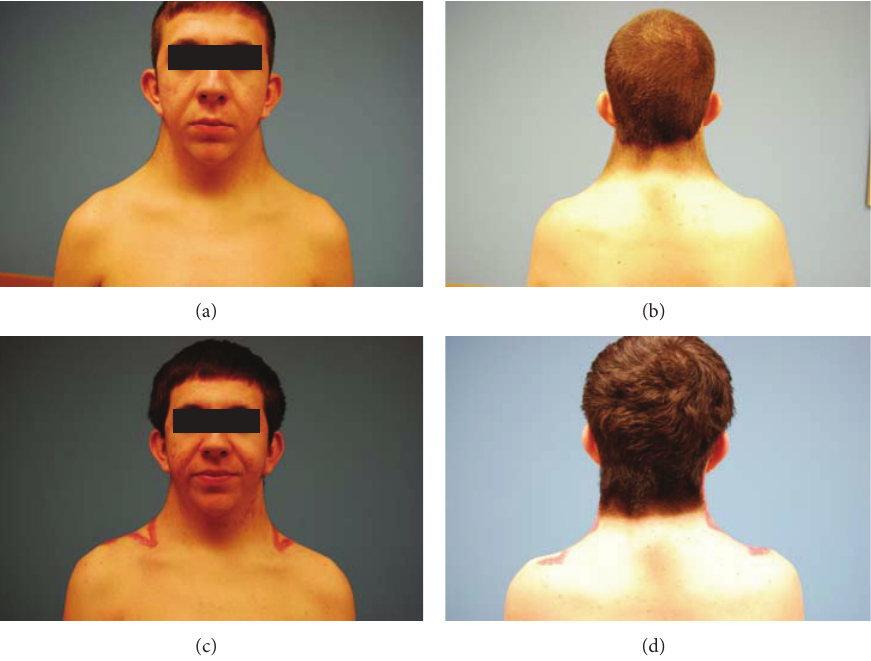
Figure 7: (a) Preoperative appearance demonstrating webbed neck deformity of Noonan syndrome; (b) preoperative low and laterally displaced nuchal hairline; (c) anterior appearance one year after surgical correction of pterygium colli with no evidence of anterior displacement of hair-bearing skin; (d) posterior appearance one year after surgical correction of pterygium colli with improved neck contour, improved nuchal hairline, and without evidence of